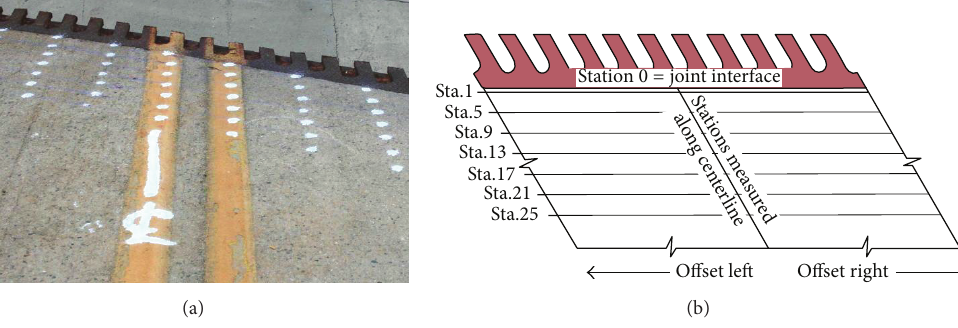
Figure 3: Reference points and mapping sequences.